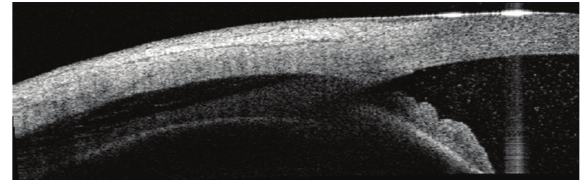
Figure 8: AS-OCT: trauma with a BB gun resulting in hyphema, angle recession, and choroidal hemorrhage.